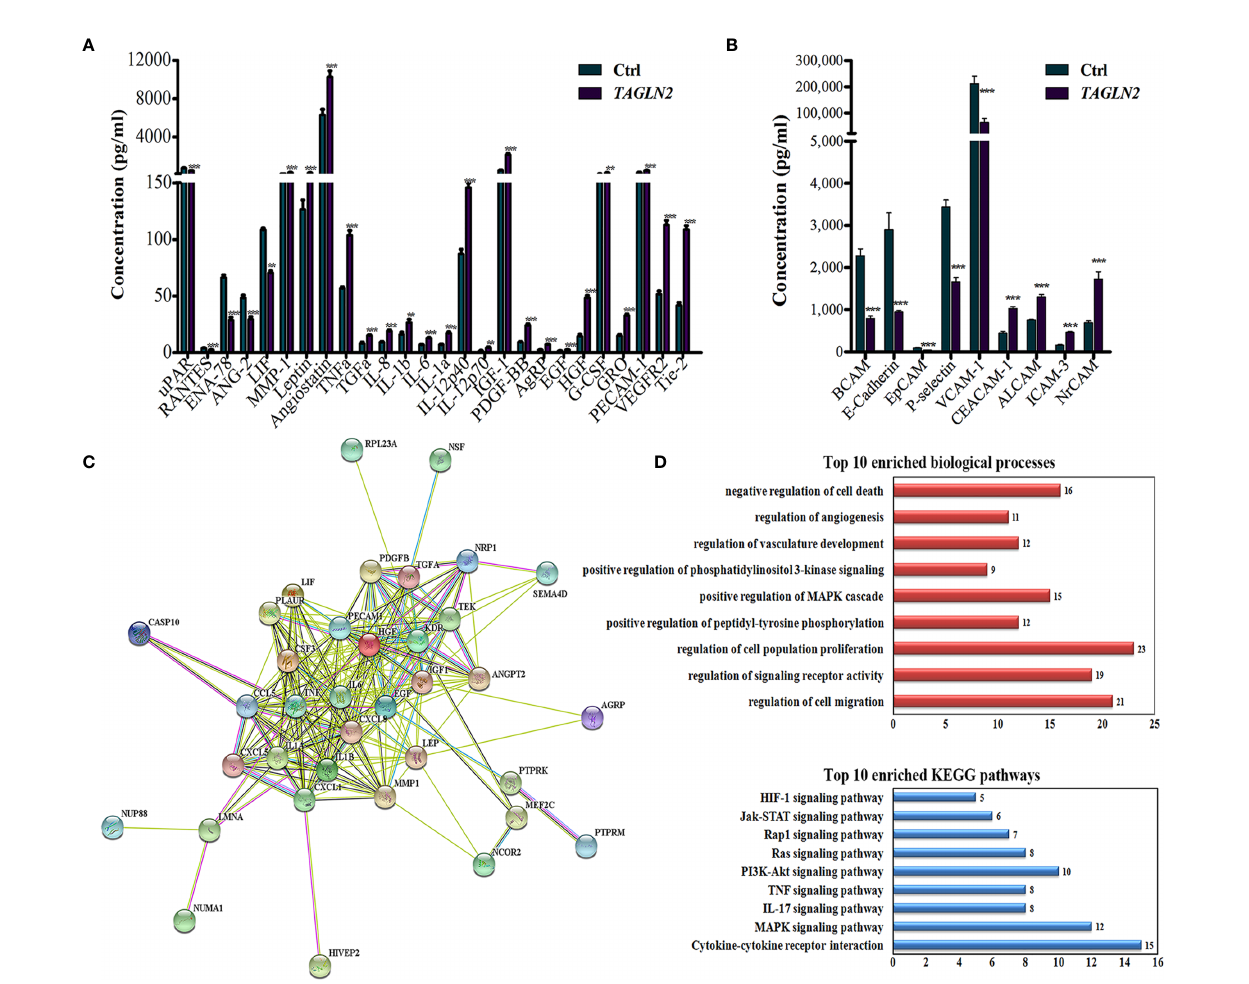
FIGURE 4 | The critical molecule and signaling pathway related to the angiogenic function of Tagln2. (A, B) Tagln2-derived expression of angiogenesis factors and adhesion molecular in ECs. Primary HUVECs infected with lentiviral expression vector directing the expression of TAGLN2 or with mock vectors were prepared. The RayBiotech Human Angiogenesis Antibody Array 1000 and Adhesion Molecule Array Q1 (Cat#QAH-ANG-2 and QAH-CAM-1) were purchased from RayBiotech Inc. (Norcross, GA, USA). Blots were scanned with an InnoScan 300 Microarray Scanner and analyzed using ImageJ software. Proteins with band densities exhibiting a fold increase of greater than 1.5 or a fold decrease of greater than 0.67 were de fi ned as differentially expressed proteins. The relationship between 26 differentially expressed proteins from the angiogenesis antibody array and 47 upregulated DEGs identi fi ed by RNA-Seq were analyzed and deeply mined using the STRING website (https://string-db.org/). A protein-protein interaction network was constructed (C) , and the corresponding Top 10 enriched biological processes and KEGG pathways (D) were shown. ** P < 0.01, *** P <